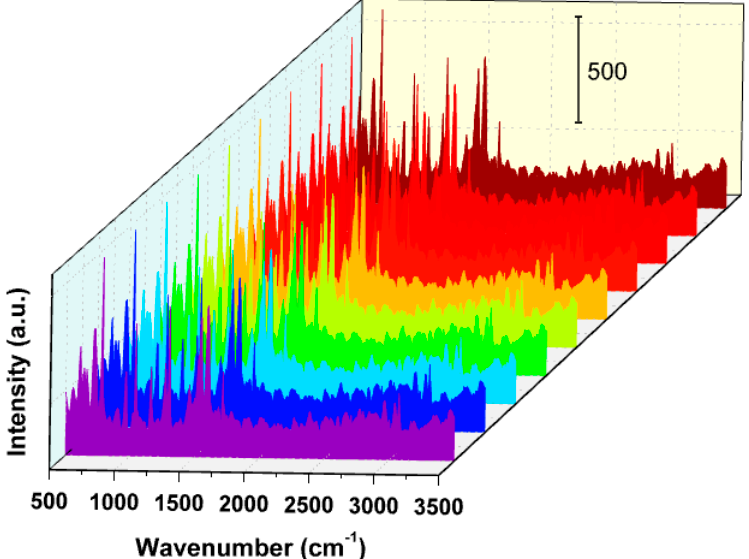
Figure 8. Raman spectra of 30 µ M thiophanate methyl collected at 10 random locations on AuNSps coated glass substrate.